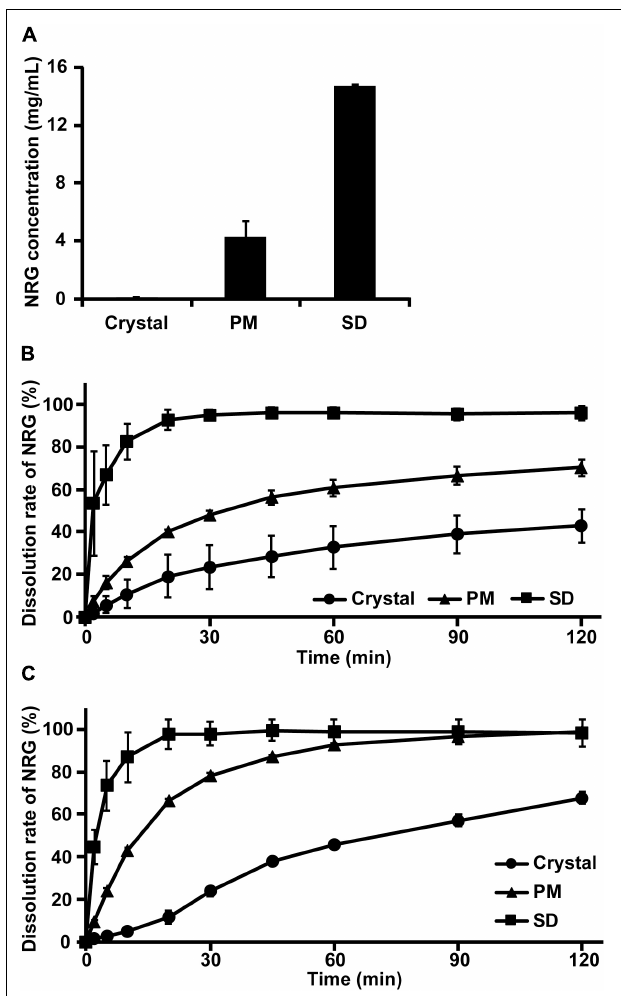
FIGURE 1 | Water solubility and dissolution rate of amorphized naringenin (NRG) solid dispersions (SD). (A) NRG solubility was determined for crystalline NRG, PM, and NRG SD suspensions in Japanese Pharmacopoeia dissolution test solution 2 (pH 6.8) (mean ± SE]; n = 3). (B) NRG dissolution rates when crystalline NRG, PM, and NRG SD were added to Japanese Pharmacopoeia dissolution test solution 1 (pH 1.2) (mean ± SE; n = 3). (C) NRG dissolution rates when crystalline NRG, PM, and NRG SD were added to Japanese Pharmacopoeia dissolution test solution 2 (pH 6.8) (mean ± SE; n = 3). For (B,C) NRG SD was thermally mixed at 200 ◦